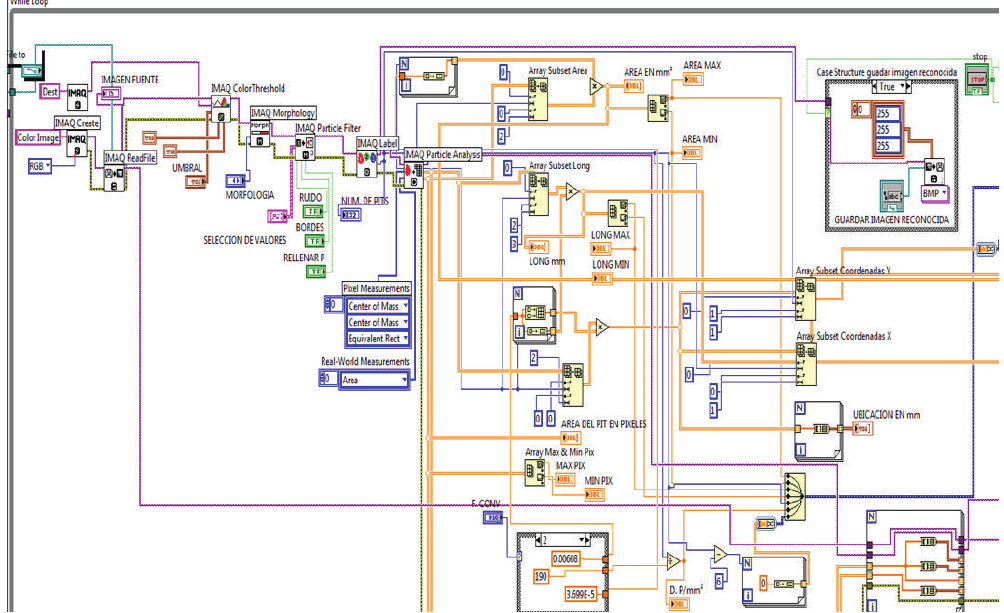
Figure 6: Blobs analysis and pixel conversion to metric